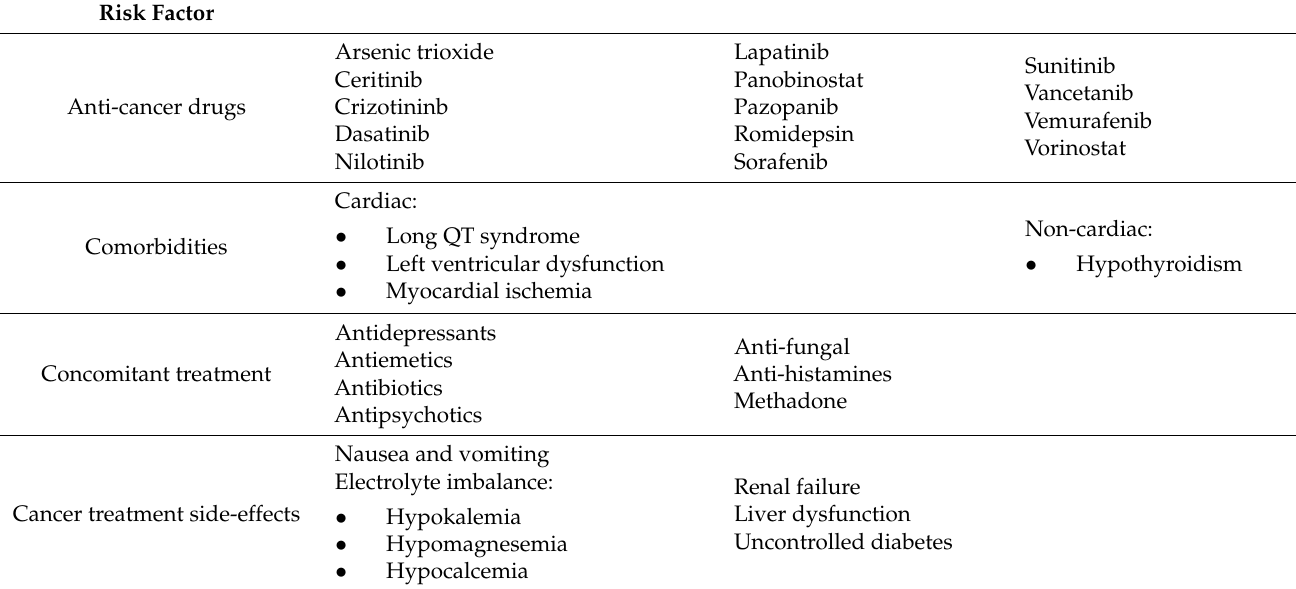
Table 2. Factors increasing the risk of QT prolongation in cancer patients